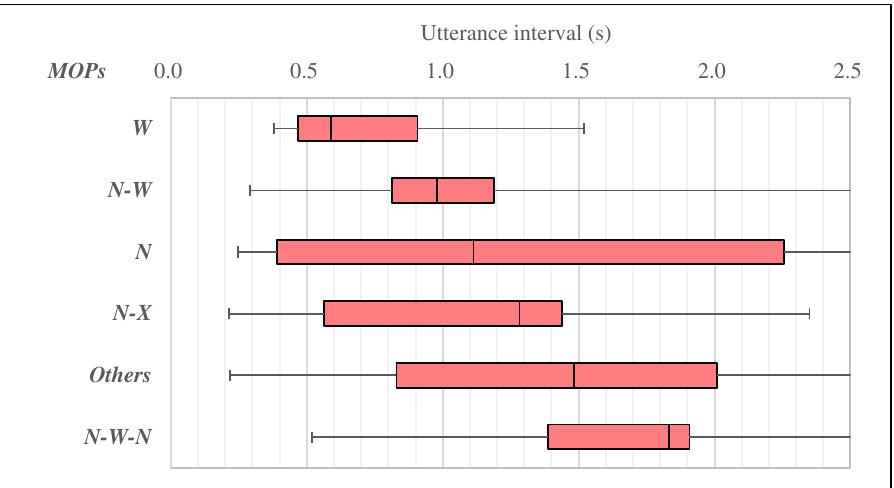
Figure 8. Box plot of utterance interval for each MOTP of current speaker during